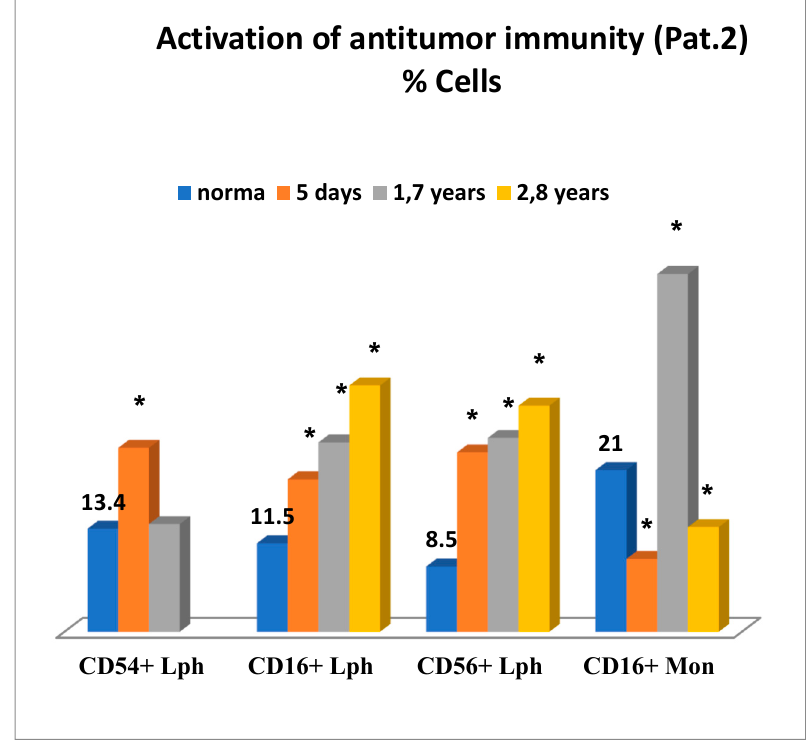
Figure 6. Activation of anti-tumor immunity in patient 2. Legend: * significance of differences; Lph = lymphocytes; Mon = monocytes; number of days = after operation.